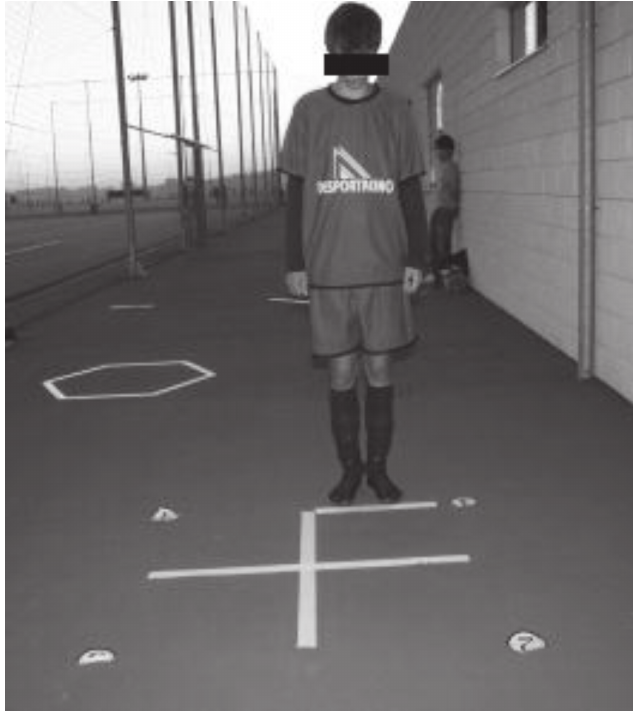
Figura 2 - Quadrant jump test